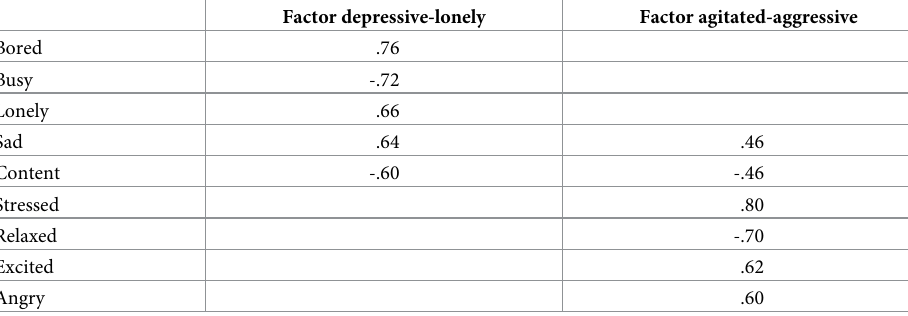
Table 1. Factor loadings from exploratory factor